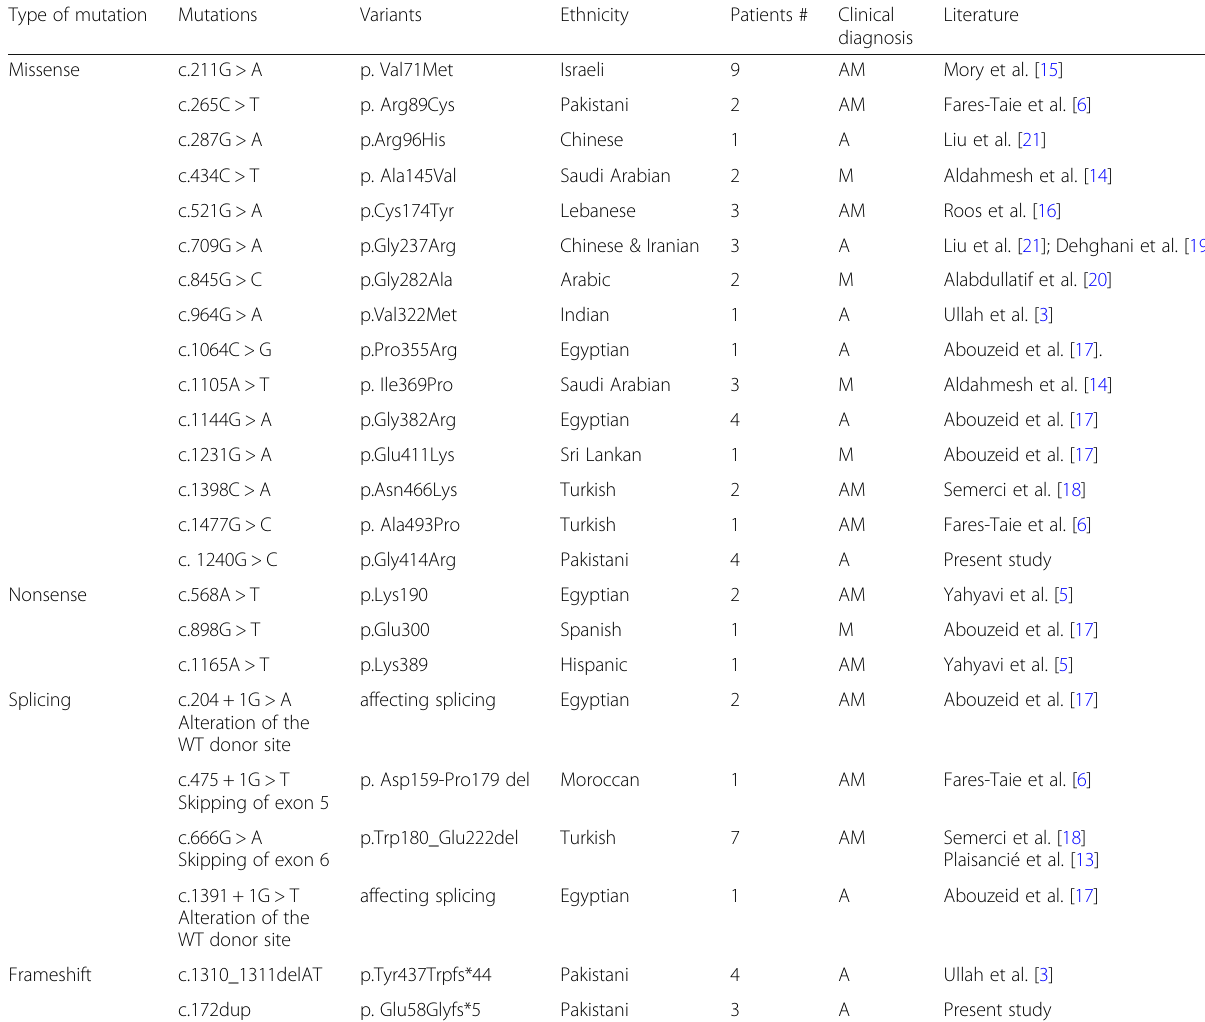
Table 1 Summary of all reported ALDH1A3 variants associated with anophthalmia and microphthalmia Type of